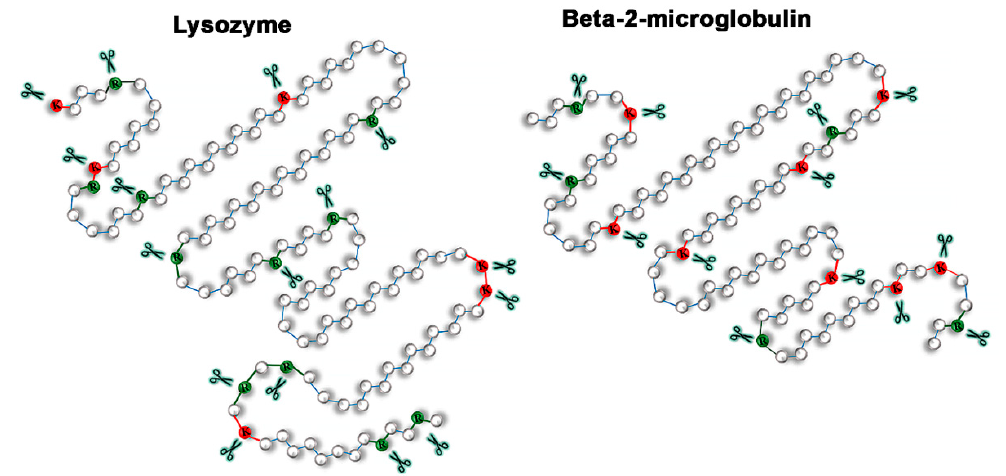
Scheme 1. Trypsin cleavage sites in the lysozyme and beta-2-microglobulin amino acid sequences. Lysine (K) and Arginine (R) amino acid residues in the primary sequence of the proteins are highlighted in red and green color, respectively.